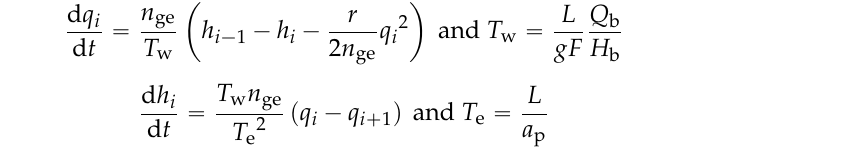
Figure 2. Scheme of the long penstock model.